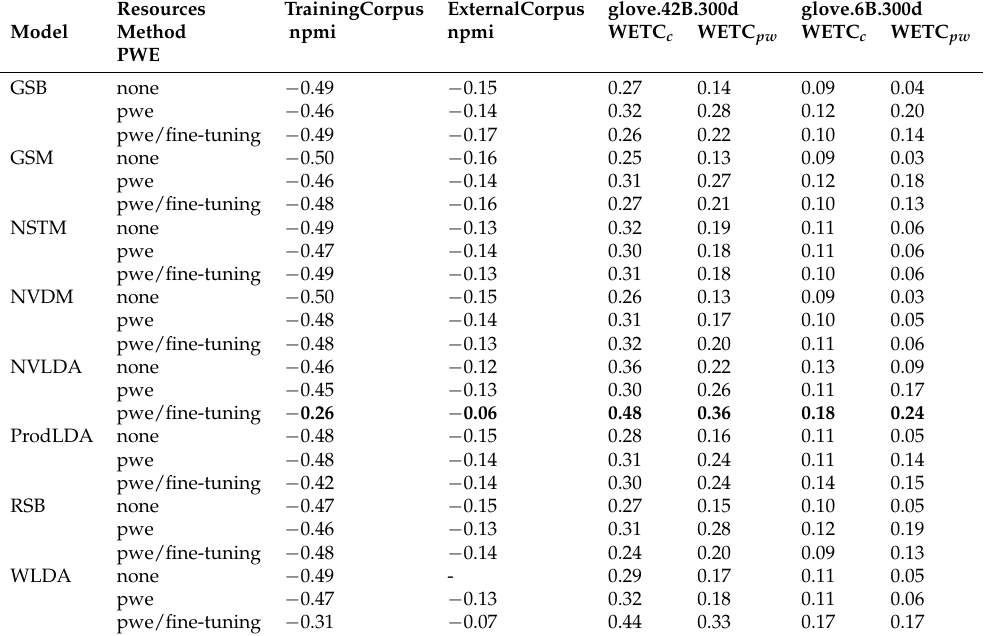
Table 10. Topic Coherence on SearchSnippets.